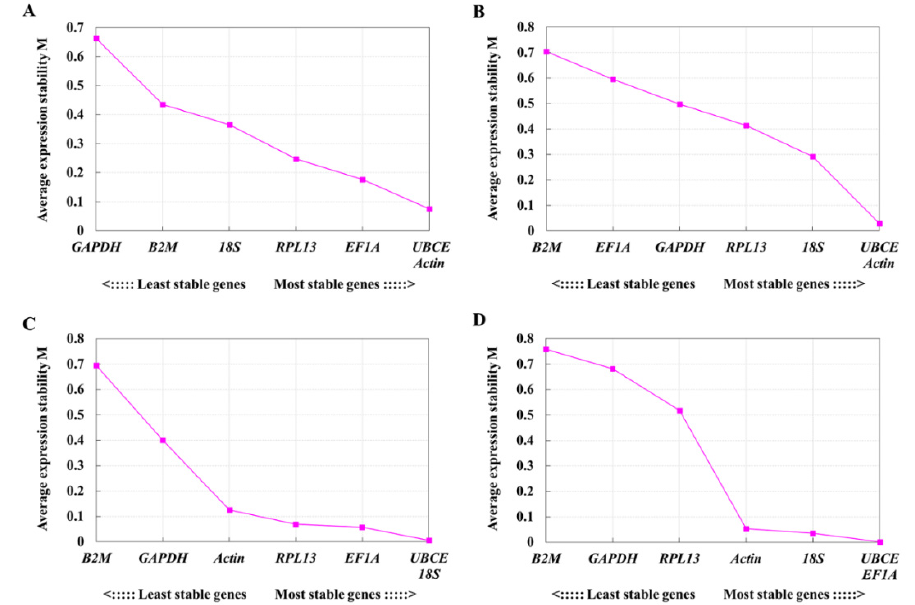
Figure 7. The expression stability of housekeeping gene candidates in GPS cells under stimulation with Poly I:C for 2 ( A ), 4 ( B ), 8 ( C ) and 12 h ( D ) assessed by geNorm. According to the C t values presented by seven housekeeping gene candidate stimulations with Poly I:C or PBS, the average expression stability of housekeeping gene candidates can be evaluated M by geNorm, and not only can the M value not be more than 1.5, but the most reliable housekeeping genes have the most minimal M value as well.